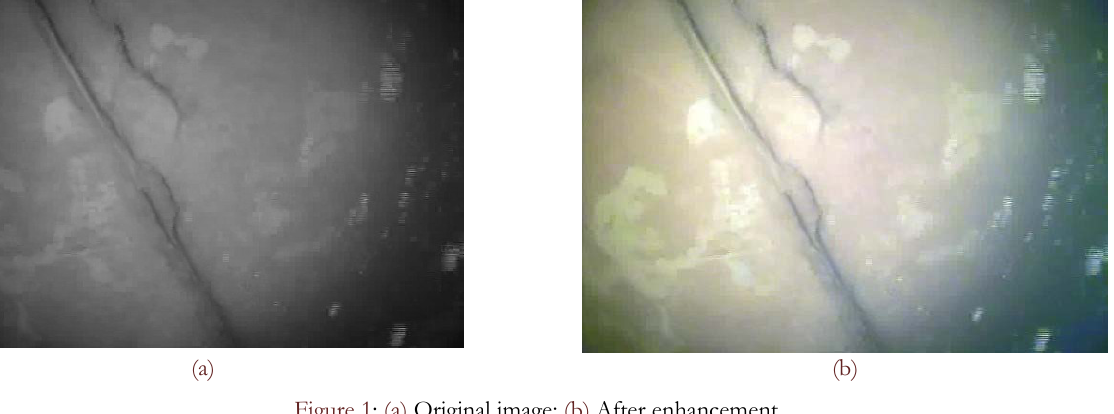
Figure 1: (a) Original image; (b) After enhancement.